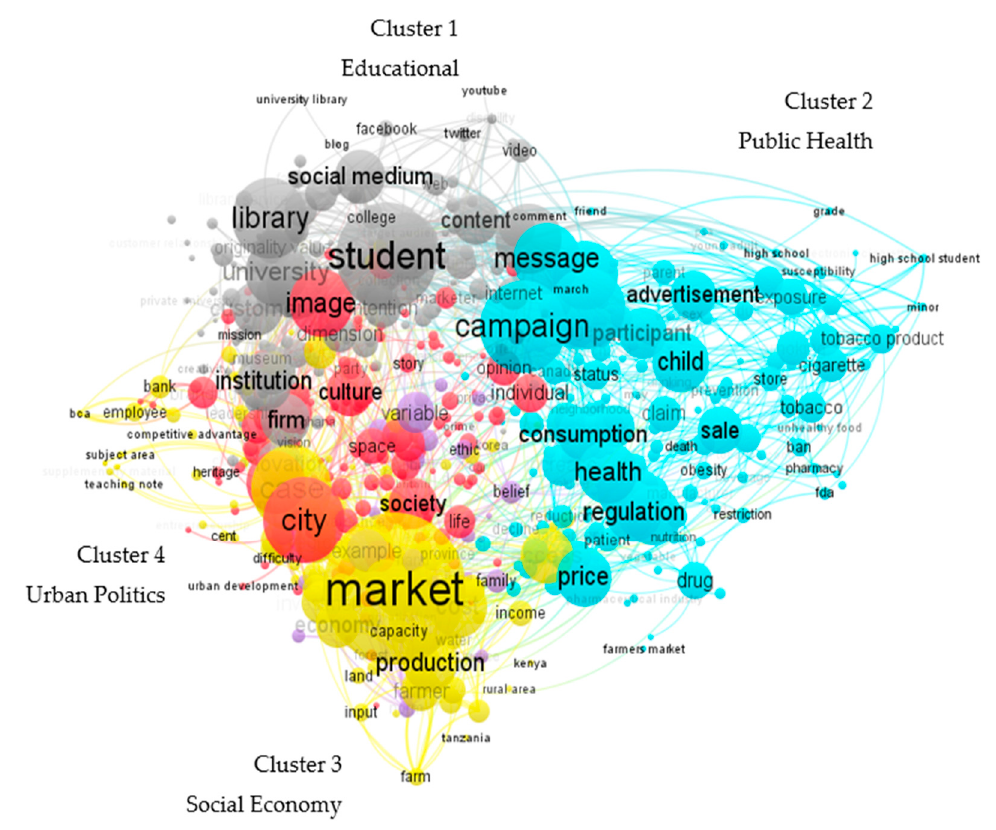
Figure 10. Map of clusters topics. Source: authors using VOS viewer software.